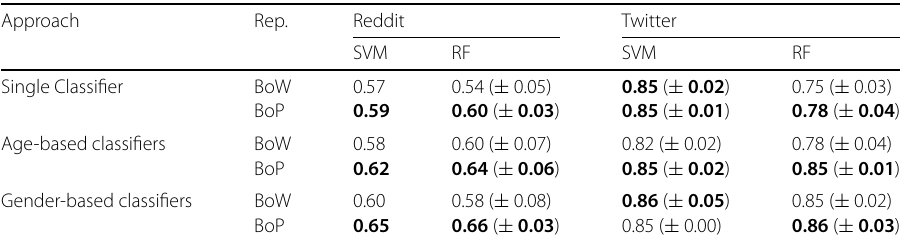
Table 5 Performance of the proposed approach using different classifiers. BoW combining specialized classifiers per users’ traits is showed as a baseline Approach Rep. Reddit Twitter SVM RF SVM RF Single